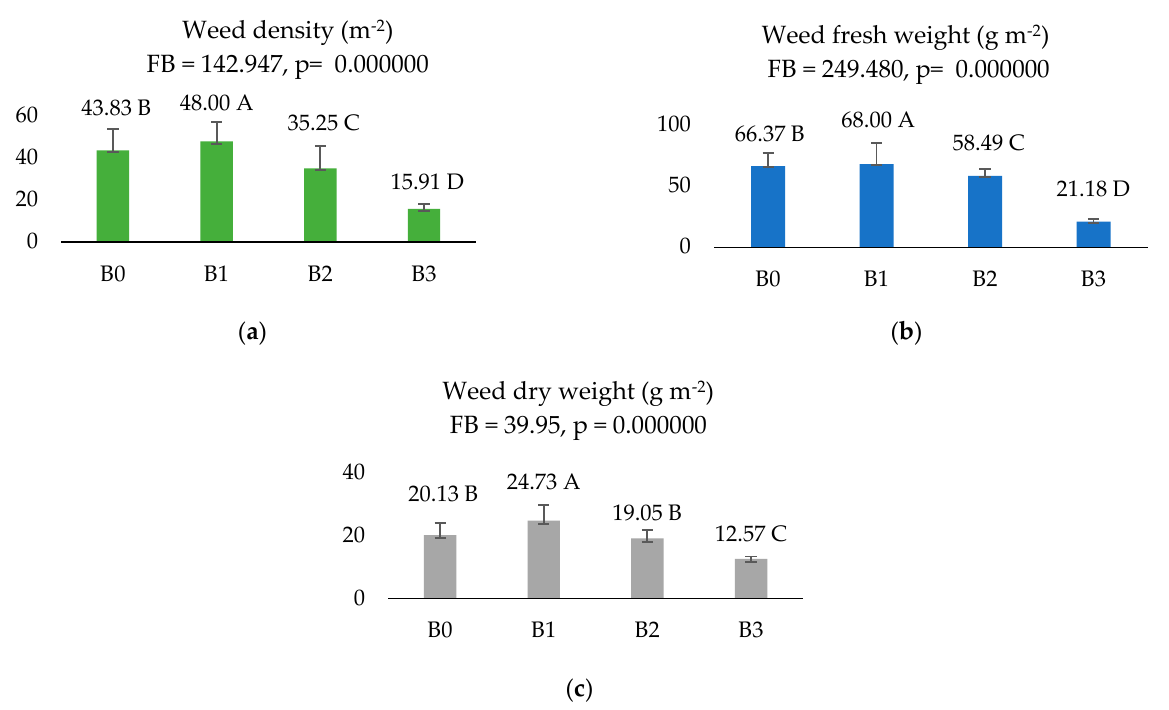
Figure 3. Influence of biochar treatments (B0-0 t ha − 1 , B1-5 t ha − 1 , B2-10 t ha − 1 , B3-15 t ha − 1 ) on weed density ( a ), weed fresh weight ( b ) and weed dry weight ( c ). FB—F-test for biochar treatments, p–p value. Columns marked with different capital letters are statistically different using the protected least significant difference (LSD) test at P < 0.05.